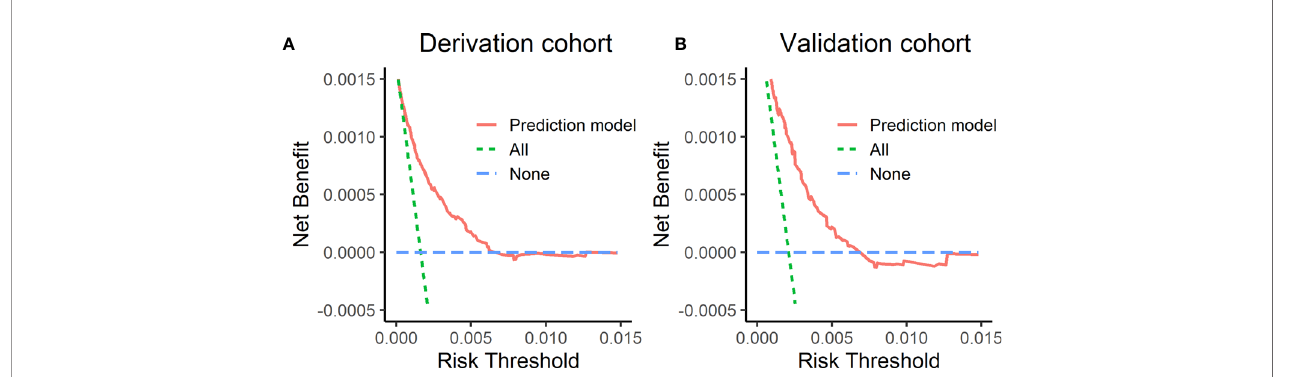
FIGURE 3 | Decision curves inthe derivation cohort and validation cohort. (A) The decision curve inthe derivation cohort, (B) the decision curve in the validation cohort. The horizontal axis of this picture was threshold probability. The ordinate axiswas the net bene fi t after the advantages were subtractedby the